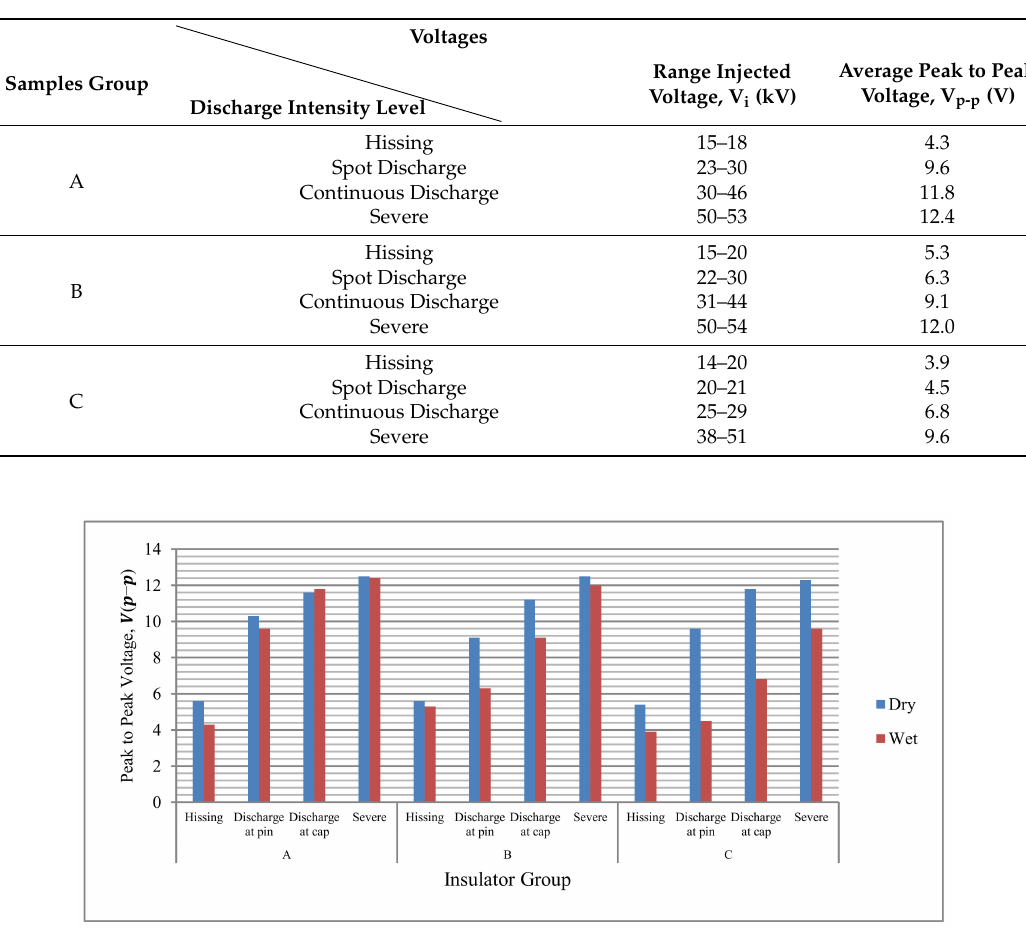
Figure 9. Peak-to-peak voltage for dry and wet conditions without